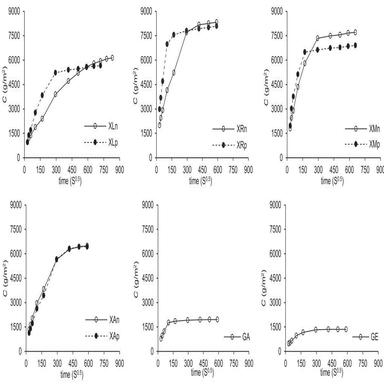
Average results for capillary absorption for each type of rock.